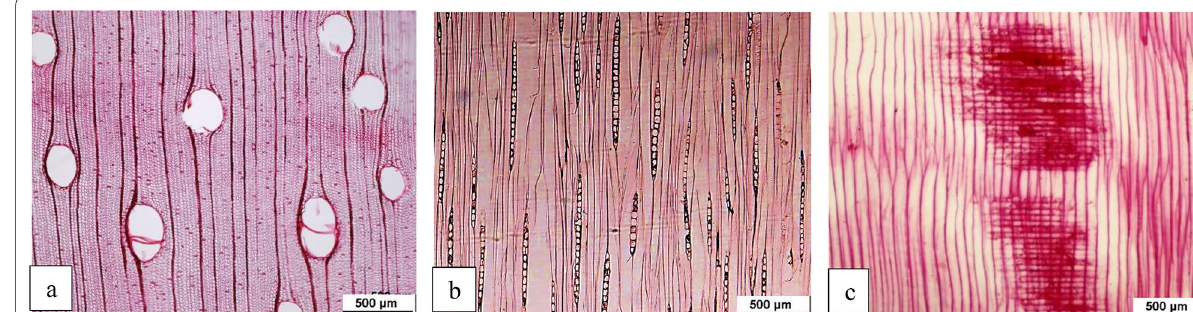
Fig. 1 Batai: ( a ) tranverse section, ( b ) tangential section, and ( c ) radial section